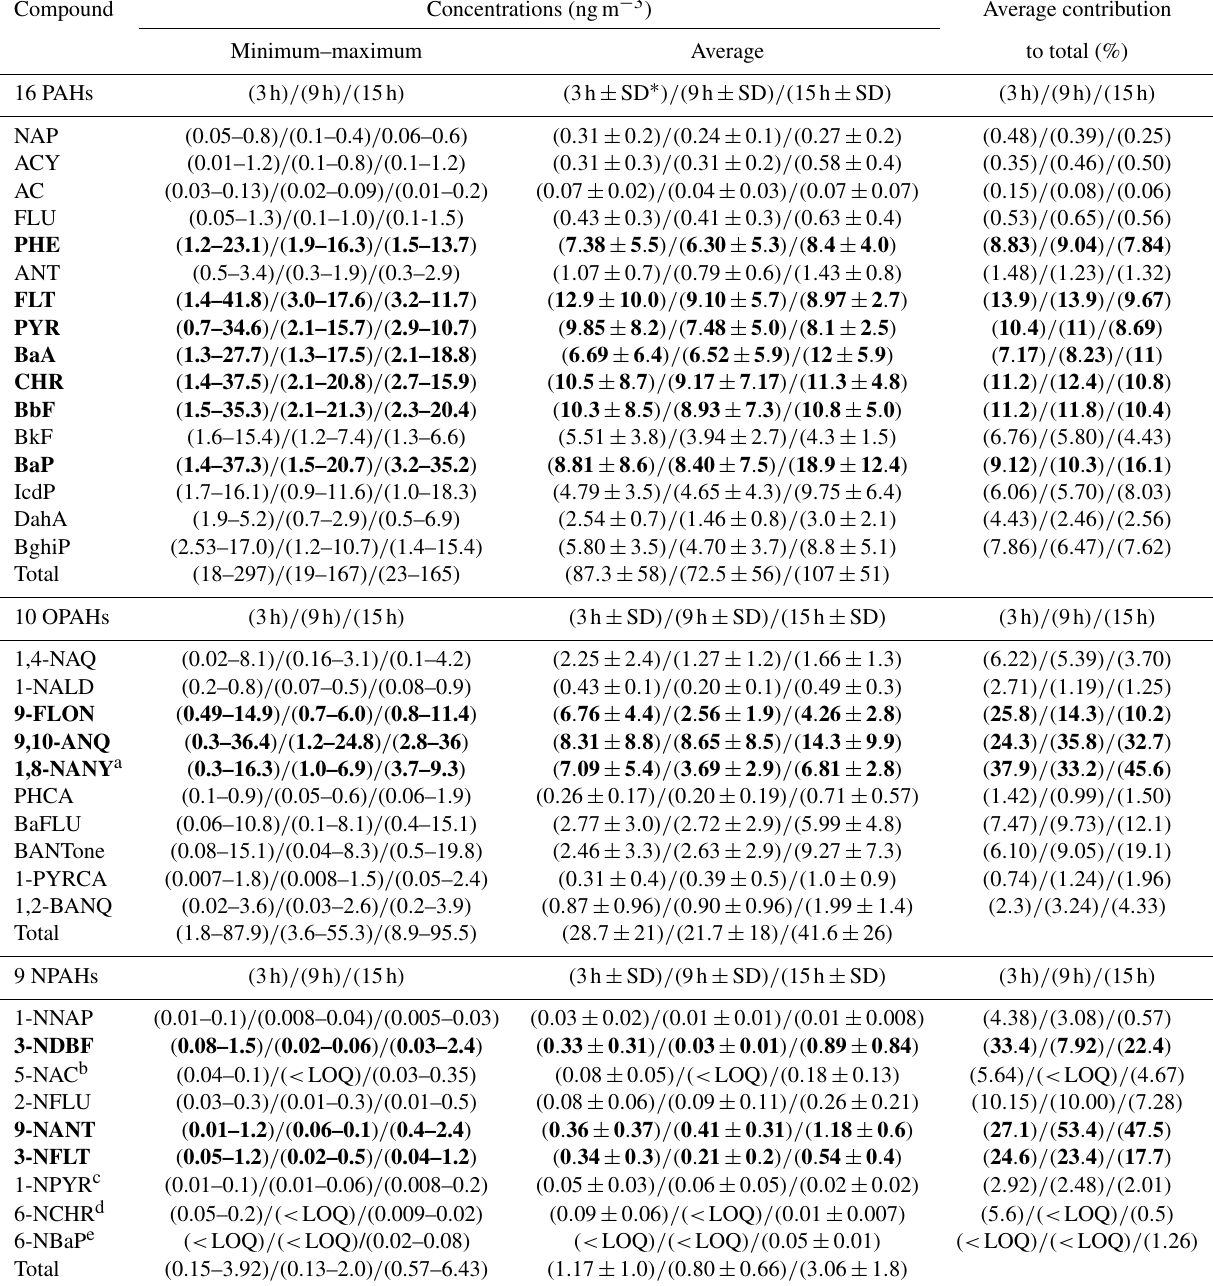
Table 2. Minimum, maximum and average atmospheric concentrations of PAHs, OPAHs and NPAHs in PM 2 . 5 . Compounds in bold represent the highest mean contribution to the sum of all